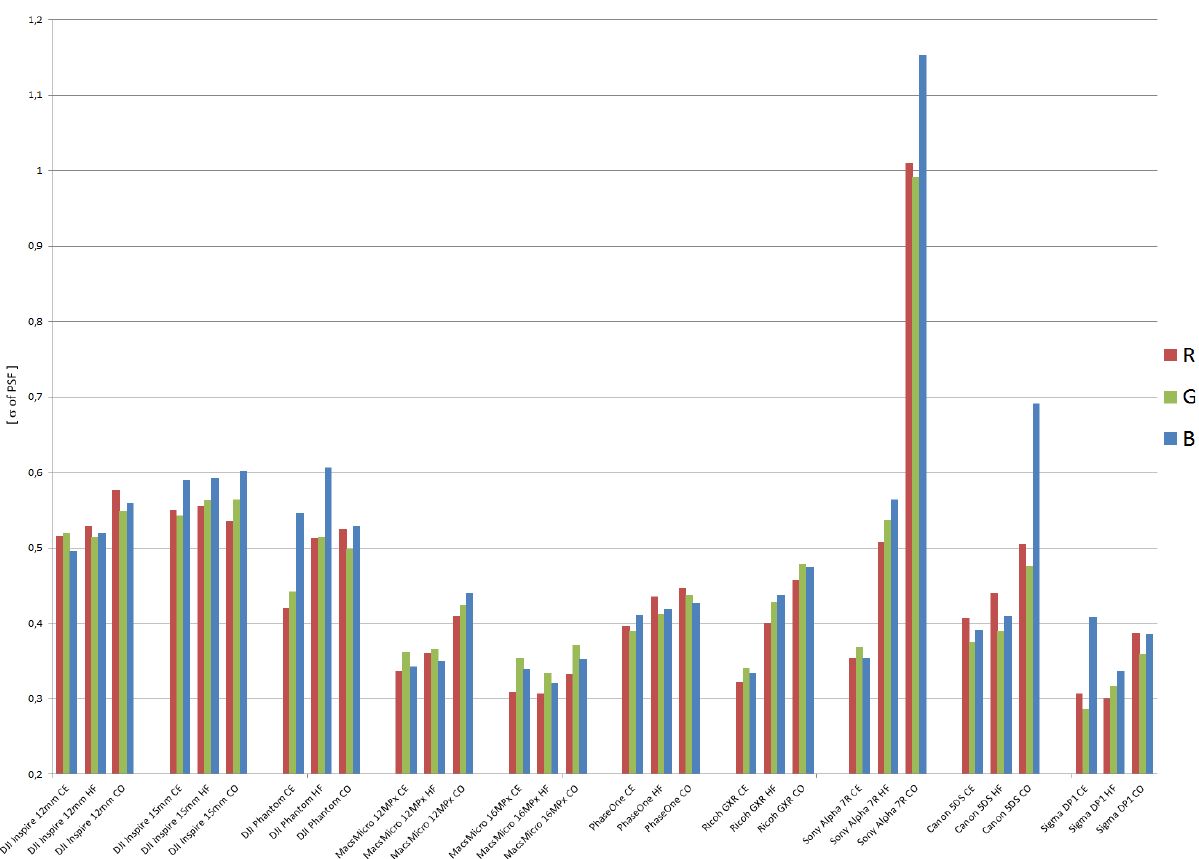
Figure 7. Results of the comparison of PSF in pixel (CE center, HF half field, CO